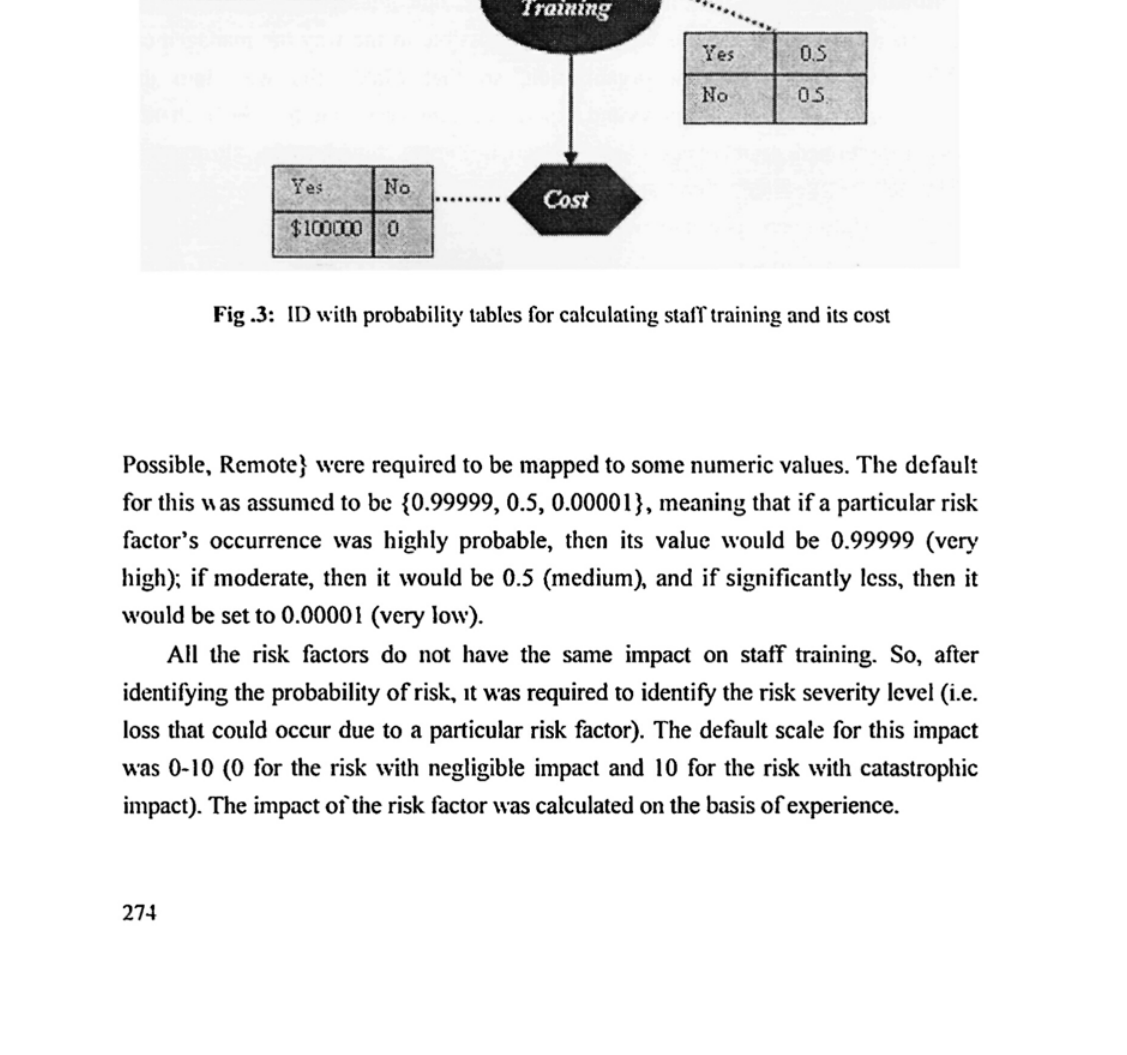
Fig .3: ID with probability tables for calculating stafT training and its cost